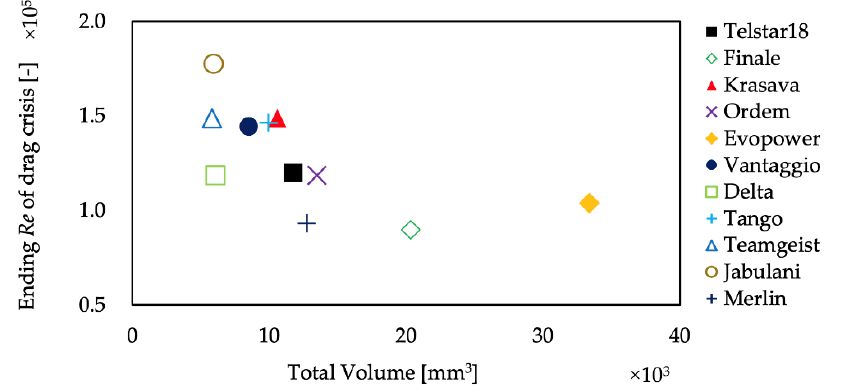
Figure 10. The relationship between the Ending Reynolds number ( Re ) of drag crisis and total groove volume.